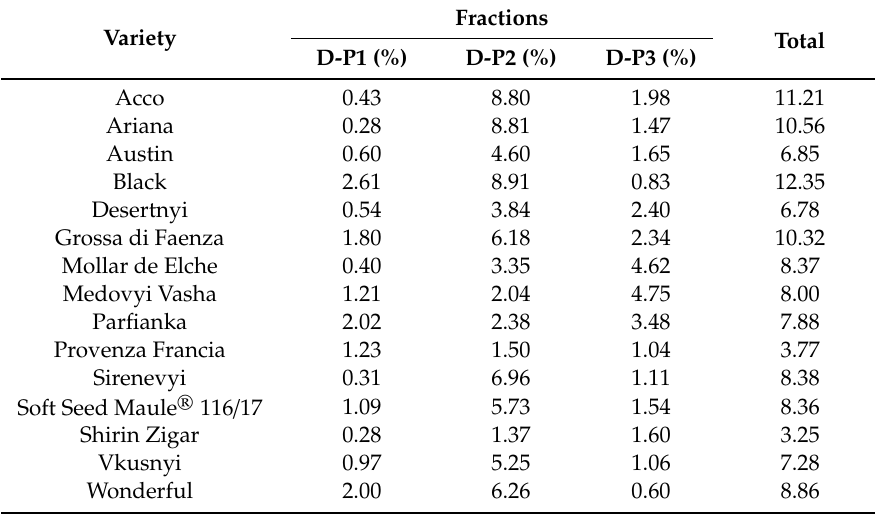
Table 4. Polysaccharide yields (%) of the three obtained fractions for each variety (D-P1, D-P2 and D-P3). Results are the mean of three independent determinations. The RSD value, evaluated on triplicates, was <